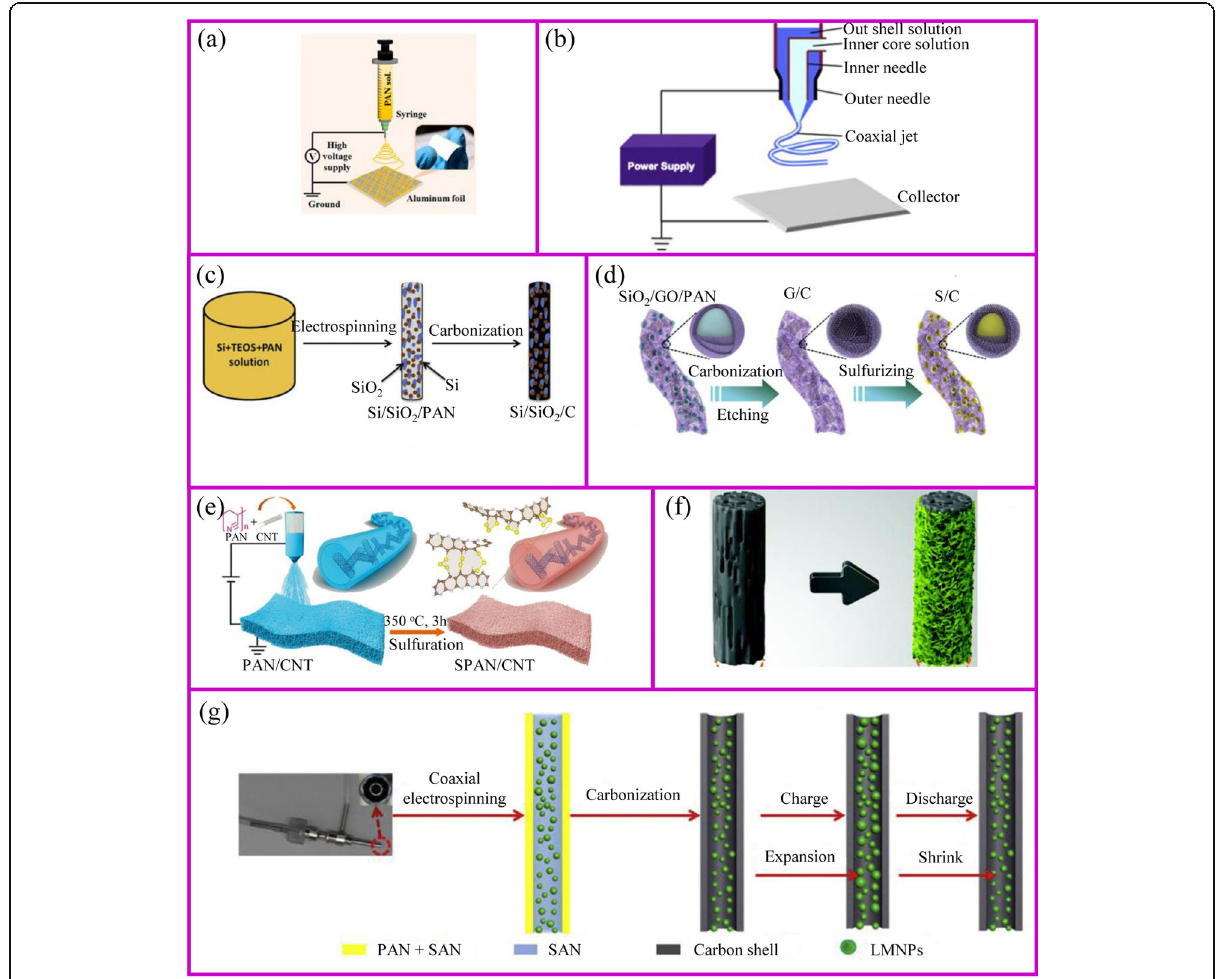
Fig. 7 The schemes of a single axial and b coaxial electrospinning [111, 112]. c Inorganic fibers [113]. d Inorganic particles encapsulated carbon fibers [114]. e The modification of carbon fibers [115]. f Carbon fiber membrane with nanoparticles [38]. g Highly flexible carbon fiber membrane